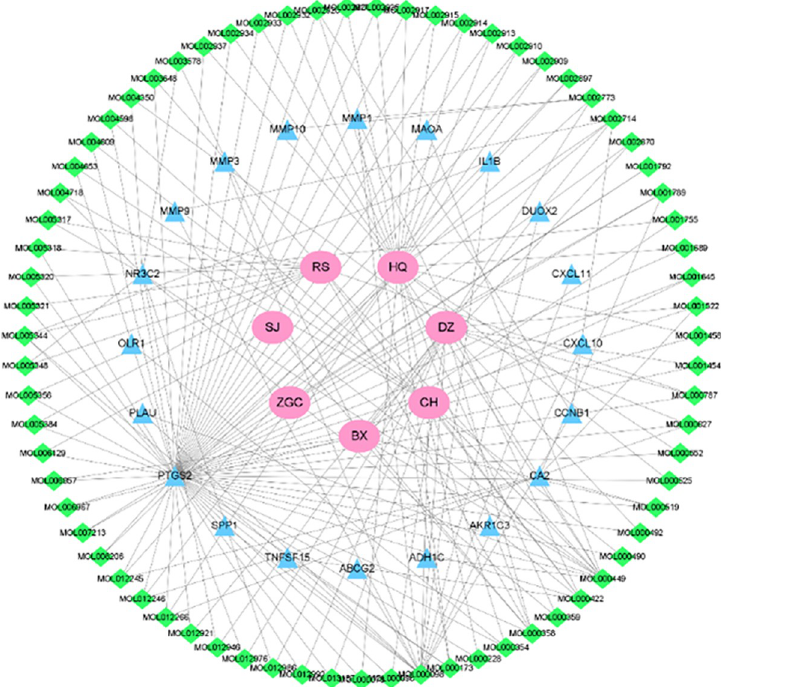
Fig 4. "Herb-active ingredient-target" network of XCHT against CRC.